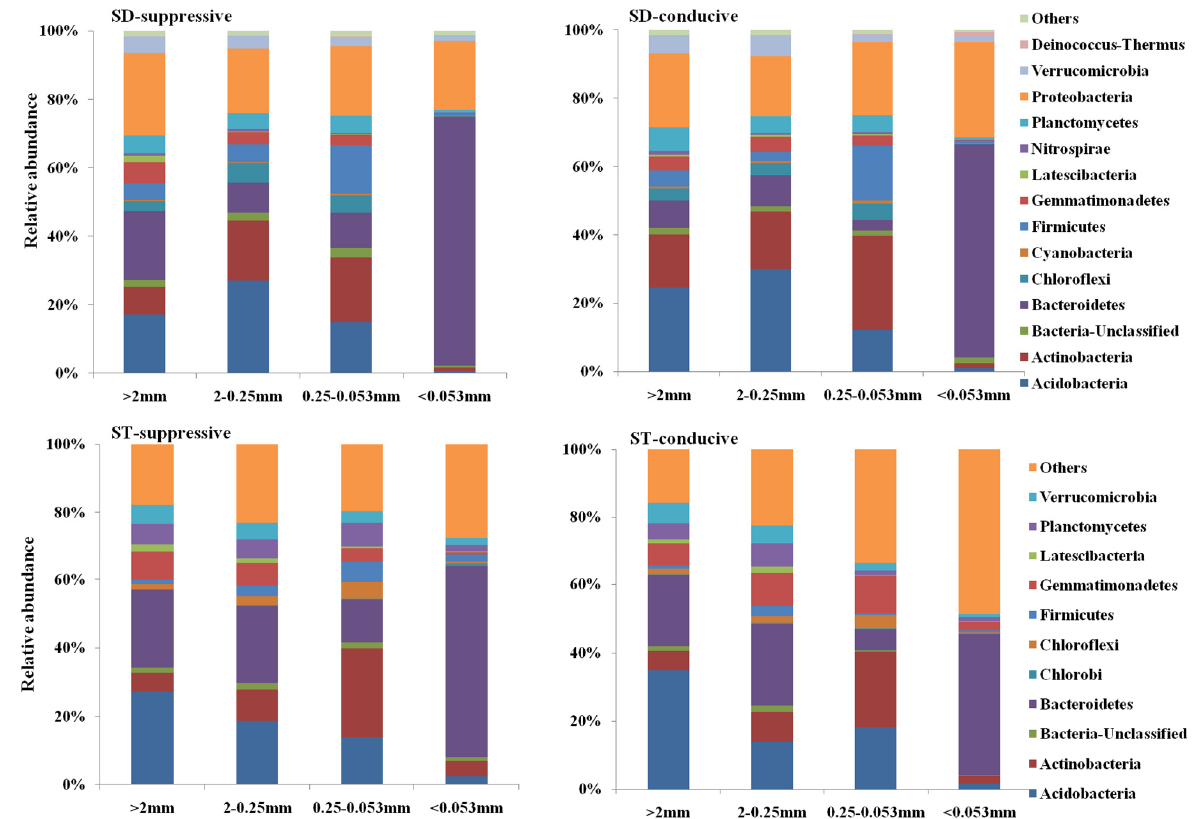
Figure 2. Relative abundance (%) of bacterial phyla present in various fractions of the suppressive and conducive soils. The phyla in various fractions with relative abundances larger than 0.03% are listed in the figure ( n = 3). “Others” indicates extremely low-abundance phyla. SD, sandy loam and ST, silt loam.